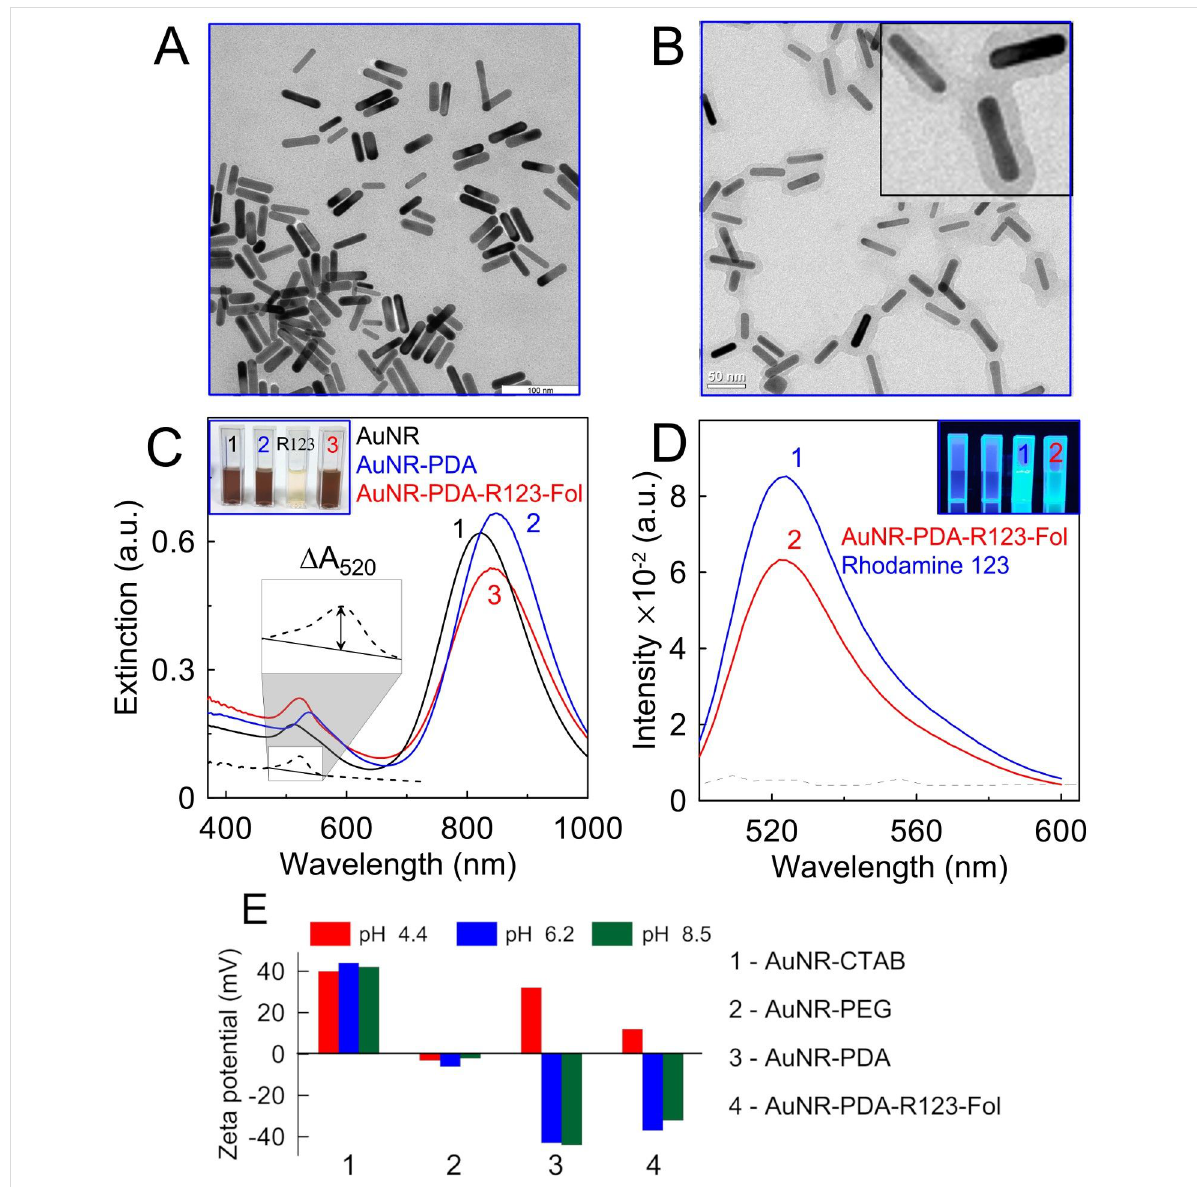
Figure 1: (A) Representative TEM image of AuNRs and (B) representative TEM image of PDA-coated AuNRs. The insert shows a magnified image. (C) Extinction spectra of as-prepared AuNRs (curve 1), PDA-coated AuNRs (curve 2), and AuNRs-PDA-R123-folate nanocomposite particles (curve 3). The dashed curve shows the differential spectrum of AuNR-PDA before and after loading of rhodamine 123. The insert shows a photo of cuvettes with as-prepared AuNRs, PDA-coated AuNRs, 1.5 µM rhodamine 123 solution and AuNRs-PDA-R123-folate nanocomposite particles under white- light illumination. (D) Fluorescence spectra of 1.5 µM rhodamine 123 solution (curve 1) and AuNRs-PDA-R123-folate nanocomposite particles (curve 2). The inset shows a photo of cuvettes with as-prepared AuNRs, PDA-coated AuNRs, 1.5 µM rhodamine 123 solution, and